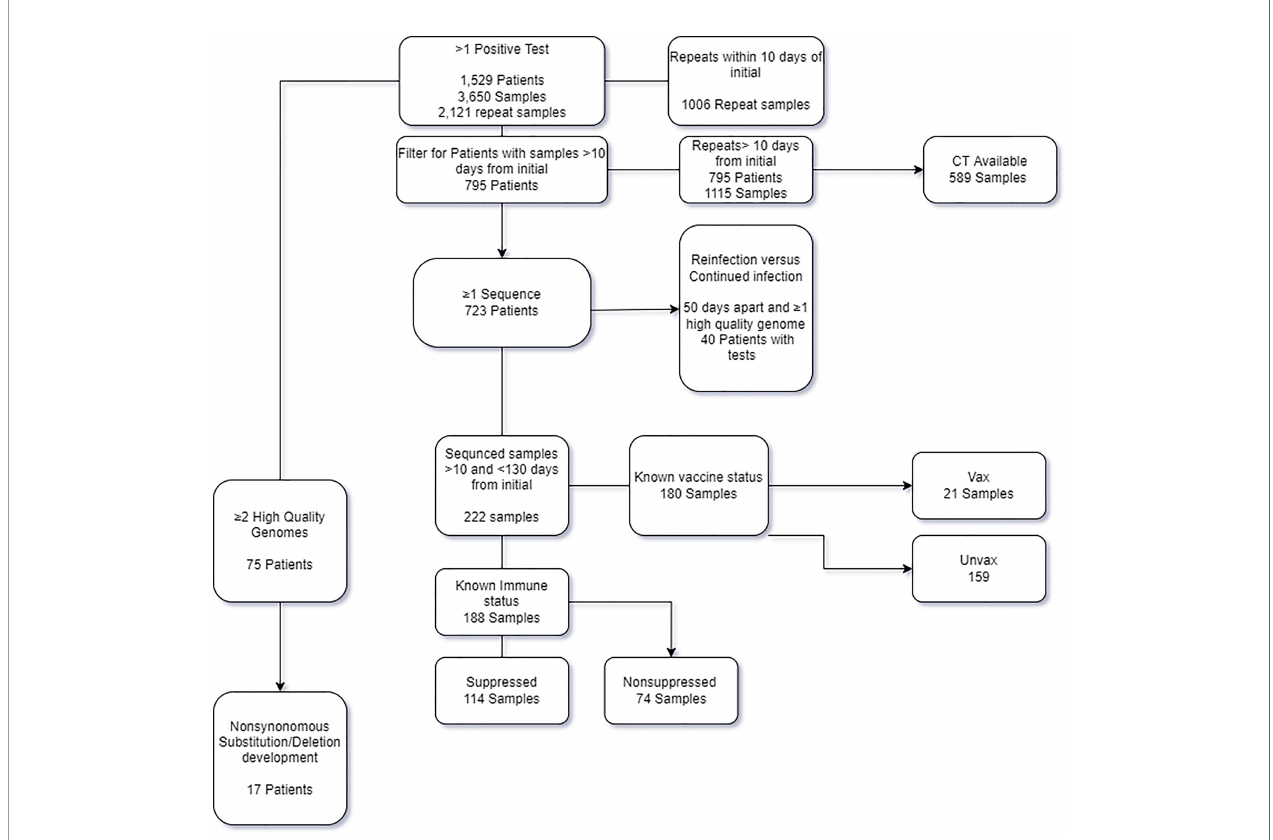
FIGURE 1 | Flow chart of the patients and samples included in the study and